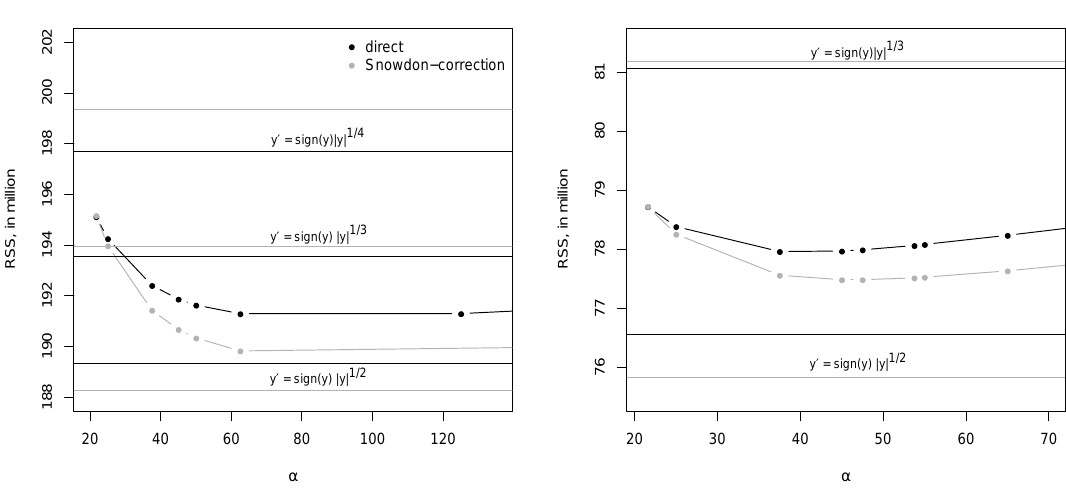
Figure 3. Residual sum of squares (in millions) for spruce and beech final models under different transformations of growth. Back-transformation was applied directly and with a correction factor [47]. The log-transformation depends on α . Horizontal lines show the root-transformations, independent of α . The fourth root transformations for the beech model are outside the plotting range. Their values are 88.5 (direct) and 89.8